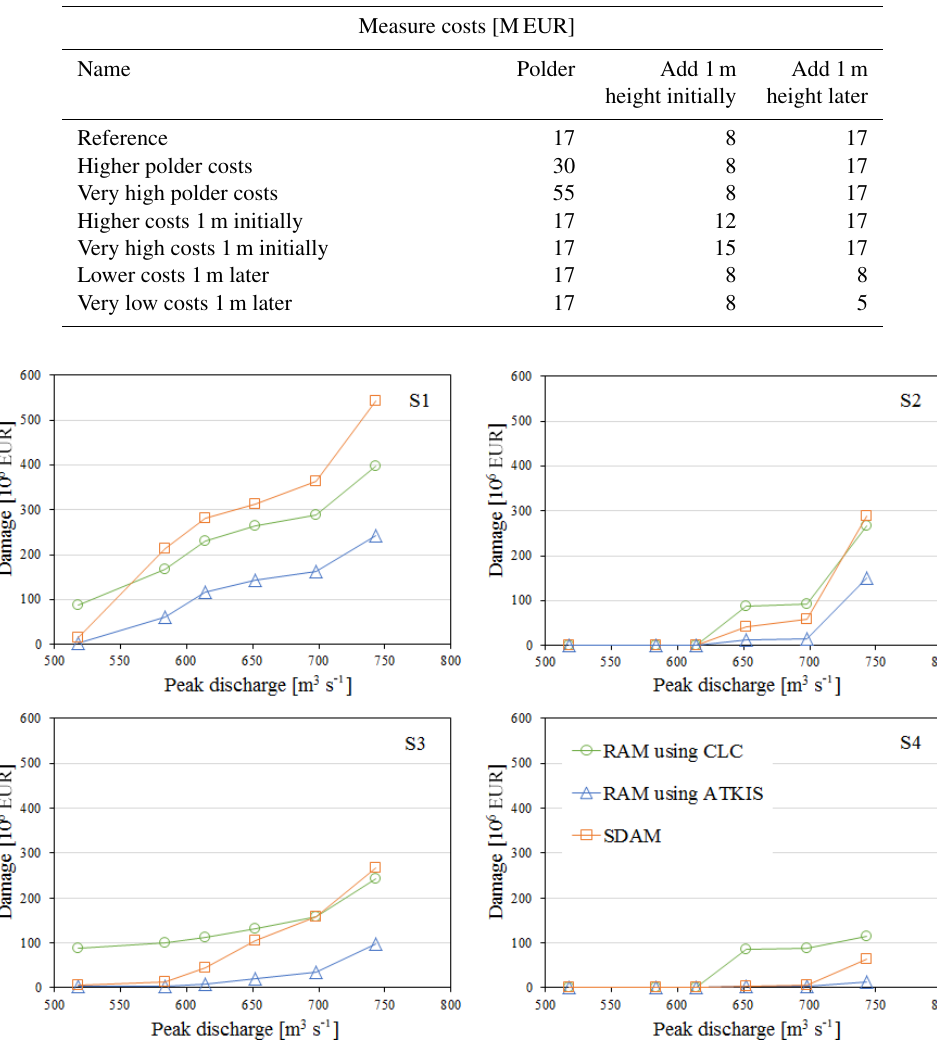
Figure 9. Estimated flood damage for four protection systems and varying peak discharges. Flood damage were calculated using the Rhine Atlas model (RAM) with different land use data sets and a simple damage assessment method (SDAM) by the Bavarian water management